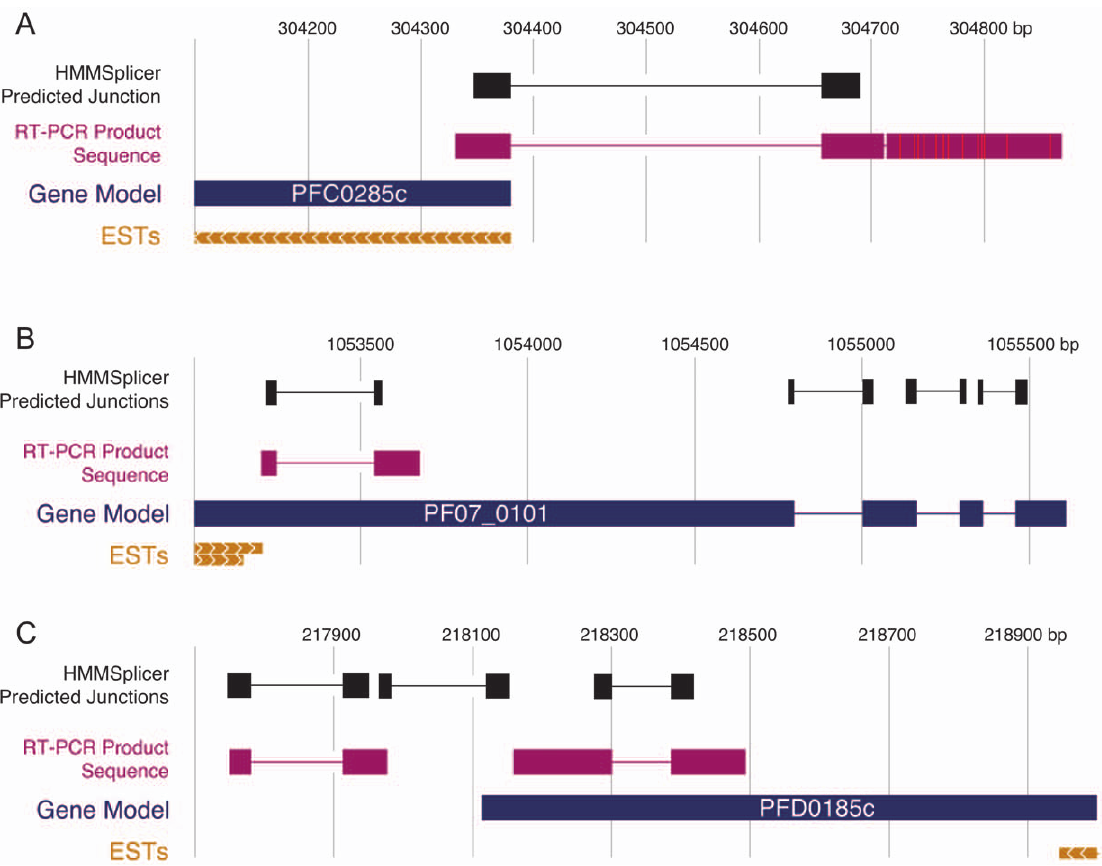
Figure 8. Experimental confirmation of predicted Plasmodiumfalciparum splice junctions. Schematics of the predicted splice junctions and sequenced RT-PCR products for a ) PFC0285c, b ) PF07_0101, and c ) PFD0185c. For PFC0285c, the verified junction likely splices an additional exon in the 5 9 UTR to the coding region of the gene. The confirmed junction in PF07_0101 splices out 291 nt (97 aa) from the first exon, which could represent an alternative protein-coding isoform, or an error in the gene model. The demonstrated junctions in PFD0185c excise 85bp near the 3 9 end of the gene, causing a frameshift, and appear to splice two exons within the 3 9 UTR of the gene together. Again, the junction within the gene model may represent an alternative splicing event or an error in the gene model. ESTs near all three areas are included to provide the direction of the genes.